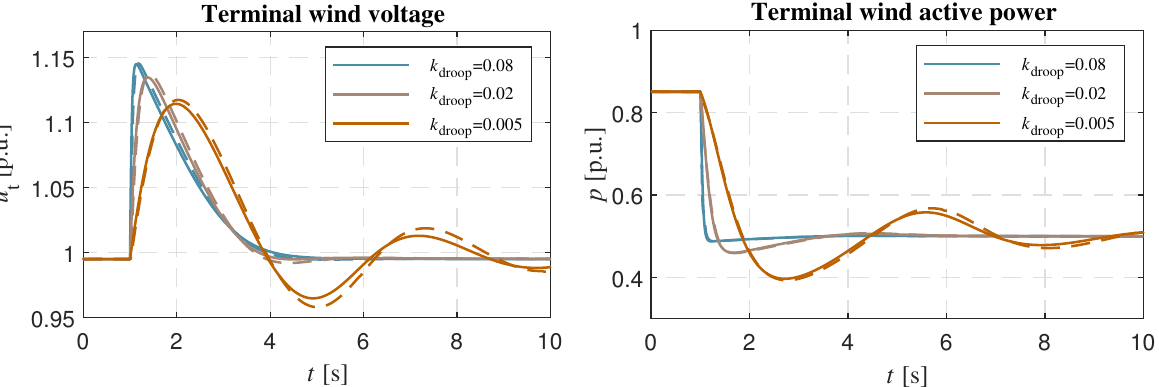
Figure 15. Response of the wind turbine to the step in active power set-point for different k droop for monolithic simulation (solid) and MOSAIK co-simulation